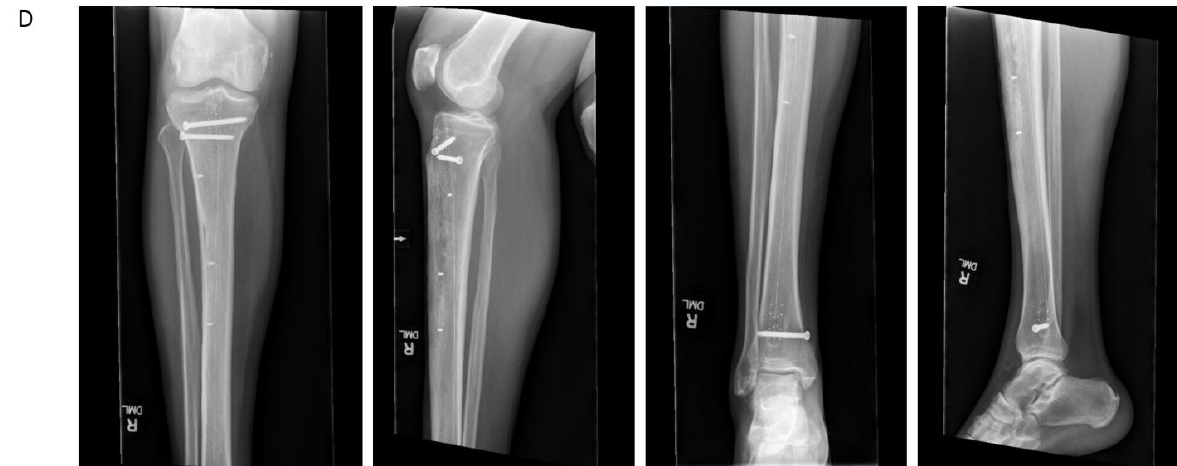
Figure 2. ( A ) Pre-operative T1 post-contrast, fat-saturation coronal; T2 fat-suppression sagittal; and T1 post-contrast, fat-saturation axial magnetic resonance images of a right tibia demonstrating a myxoid liposarcoma. ( B ) Post-operative radiographs demonstrating interval placement of an intramedullary carbon fiber nail. Note is made of a cortical defect in the tibia to allow for adequate resection margins; as such, a carbon fiber was placed for fracture prophylaxis. ( C ) The 9-month post-operative T1 post-contrast, fat-saturation coronal; T2 fat-suppression sagittal; and T1 post-contrast, fat-saturation axial magnetic resonance images demonstrating interval resection of the myxoid liposarcoma. Reduced artifact from carbon fiber nail facilitated visualization of the resection bed for monitoring of local recurrence. ( D ) The 20-month post-operative radiographs of the right tibia with intramedullary carbon fiber nail in place and healed cortical defect from prior resection margin.